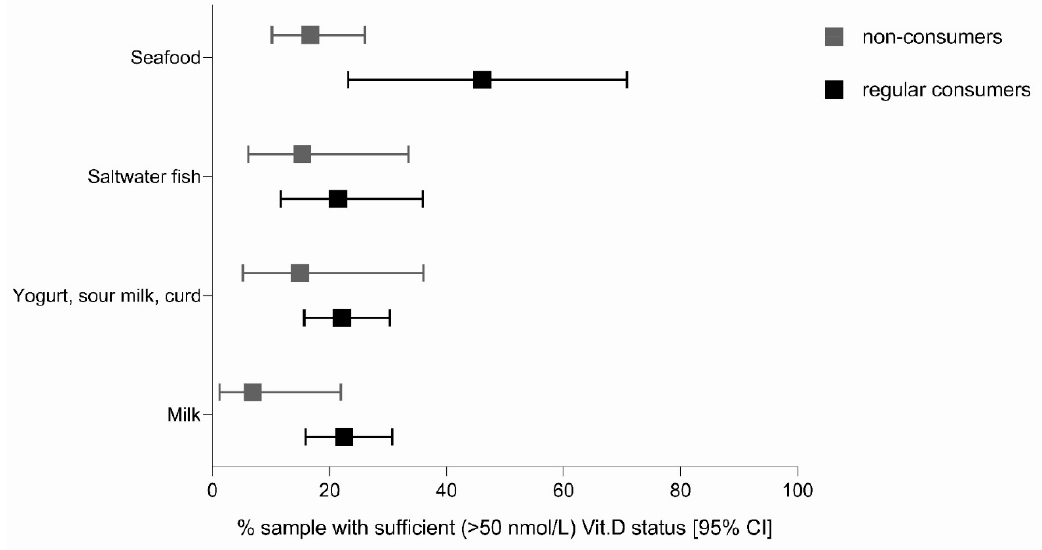
Figure 2. Proportion (%) of subjects with sufficient vitamin D status (serum 25(OH)D level >50 nmol/L) for (non)consumers of selected dietary sources of vitamin D (aggregated data for adults and the elderly during the extended winter period (November–April); n = 164).